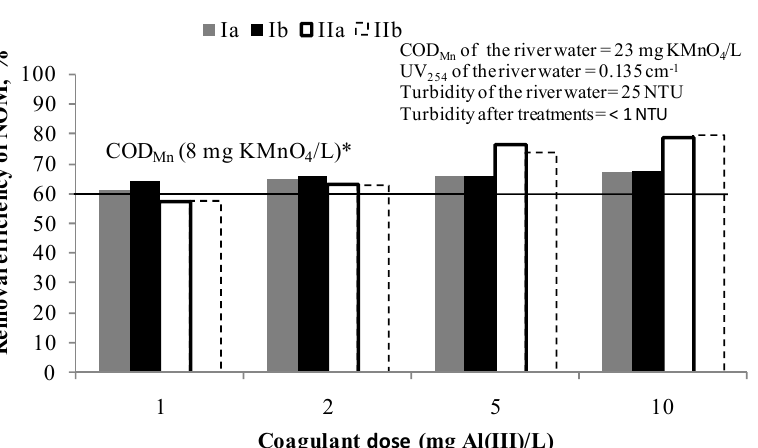
Figure 1. Removal efficiency of NOM by C/F/S at doses: 1, 2, 5 and 10 mg Al(III)/L. Note: Ia—removal efficiency (COD Mn ) in experiment; Ib—removal efficiency (COD Mn ) in experiment du-